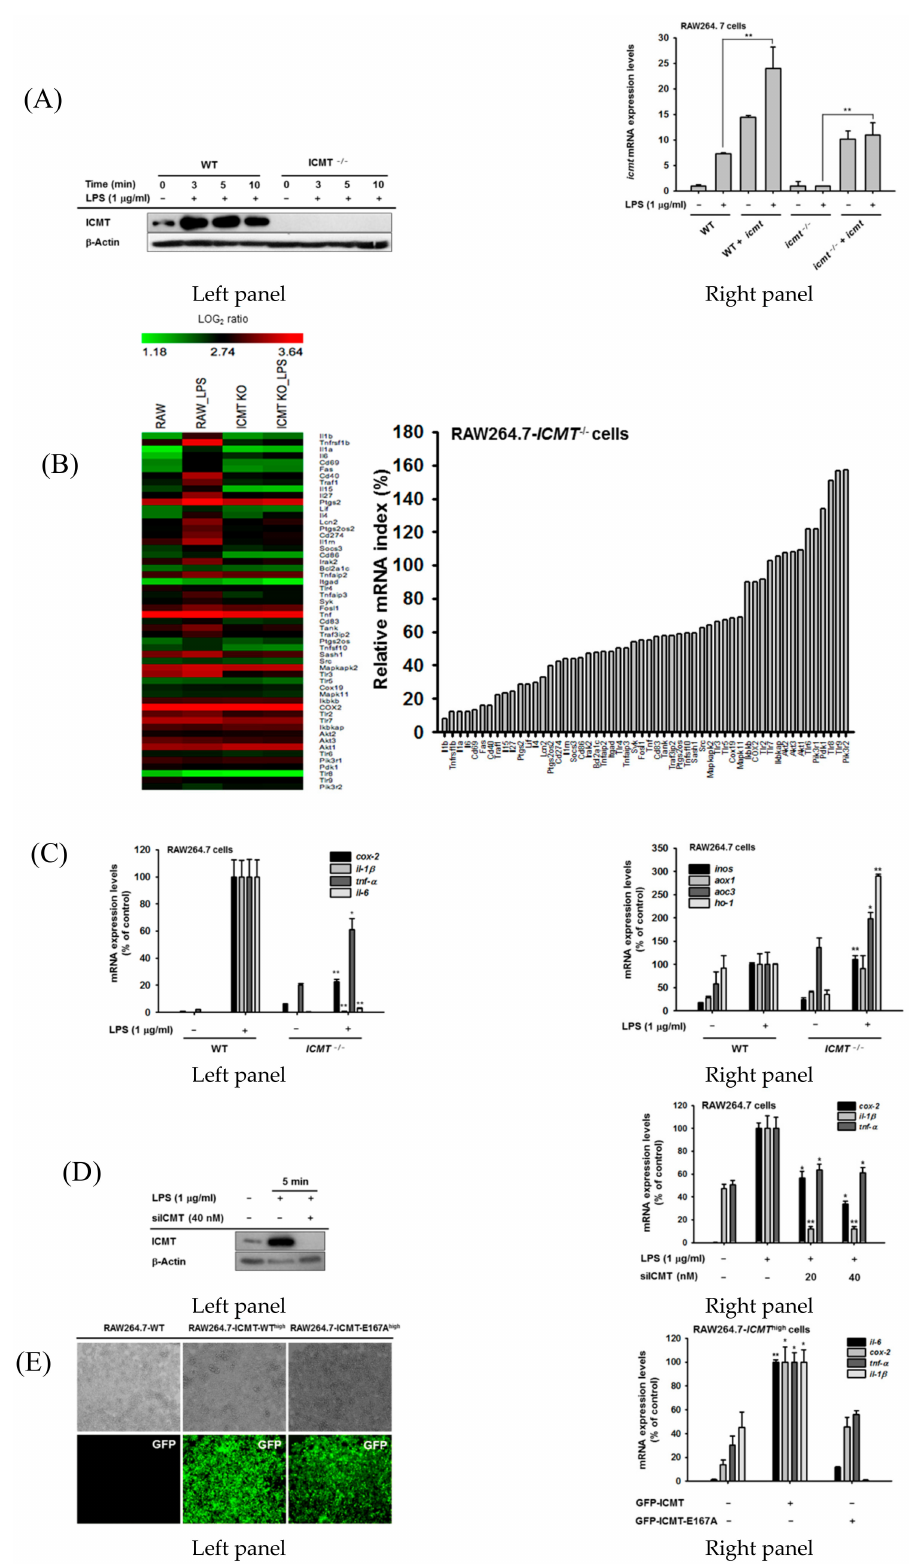
Figure 2. Functional and expressional suppression of ICMT reduces inflammatory responses in vitro and in vivo. (( A ), left panel) Protein levels of ICMT in RAW264.7- ICMT − / − cells (constructed using the CRISPR / Cas9 system) during LPS (1 µ g / mL)